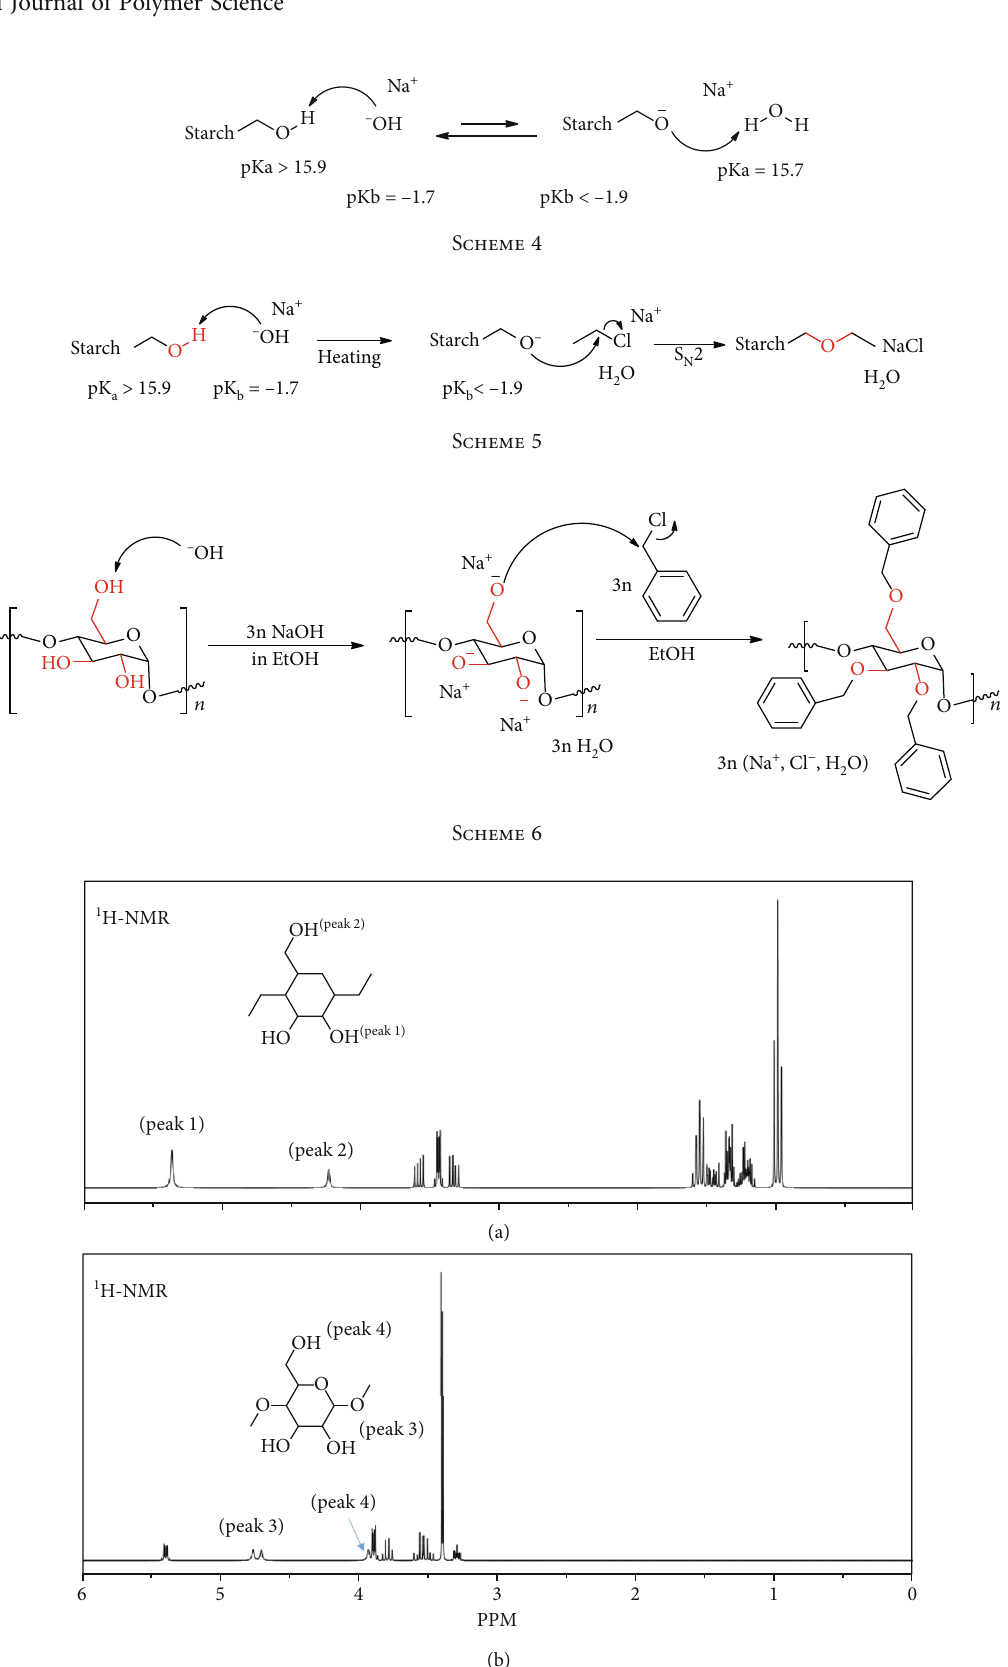
Figure 4: Simulated 1 H-NMR data on the protons of the hydroxyl groups of cyclohexane without an ether structure (a) and glucose structure